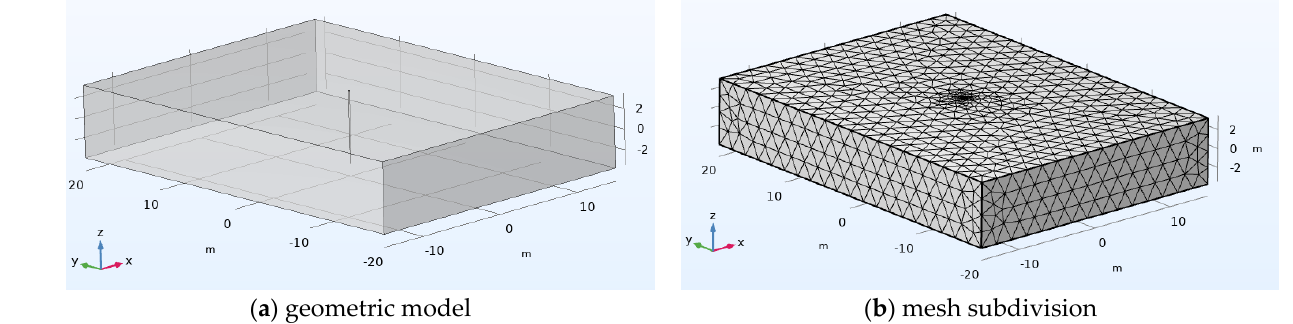
Figure 1. Geometric model and meshing. Table 1. Table of parameters required for simulation.